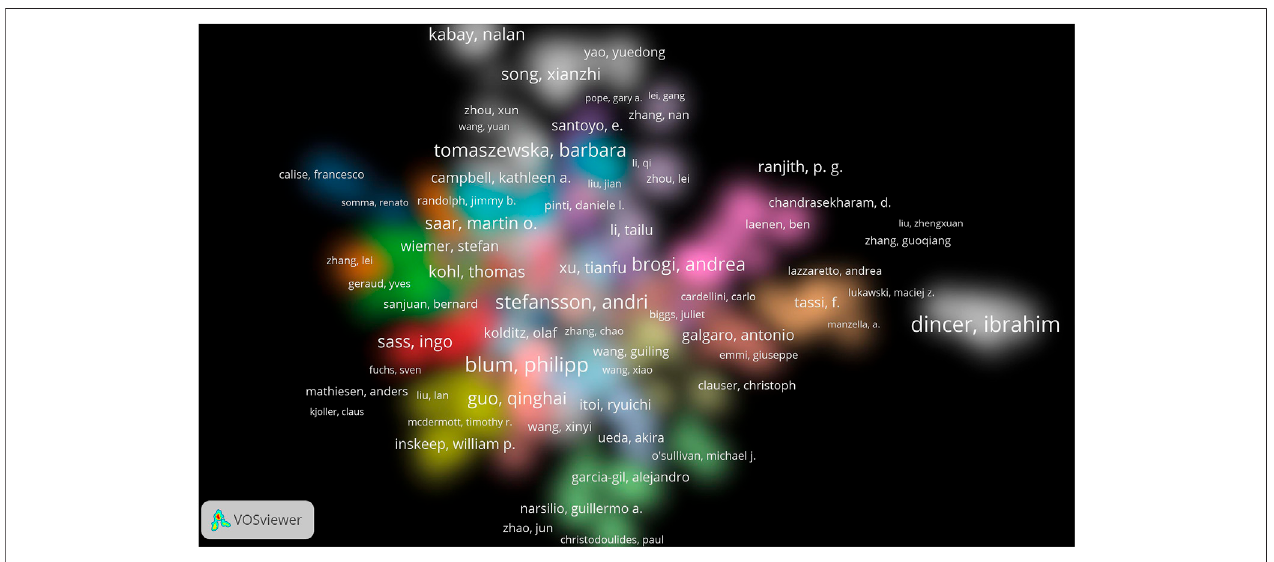
FIGURE 6 | Density view about